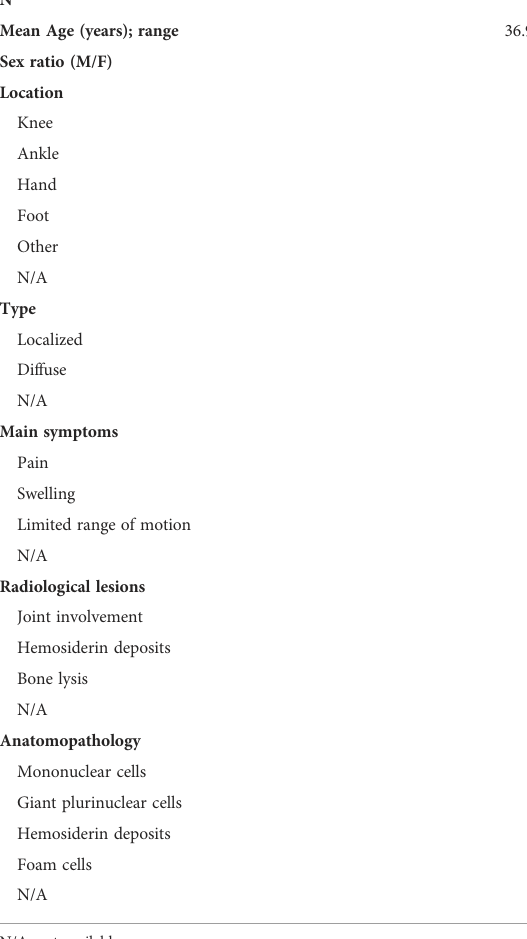
TABLE 1 Clinical characteristics of the investigational series of